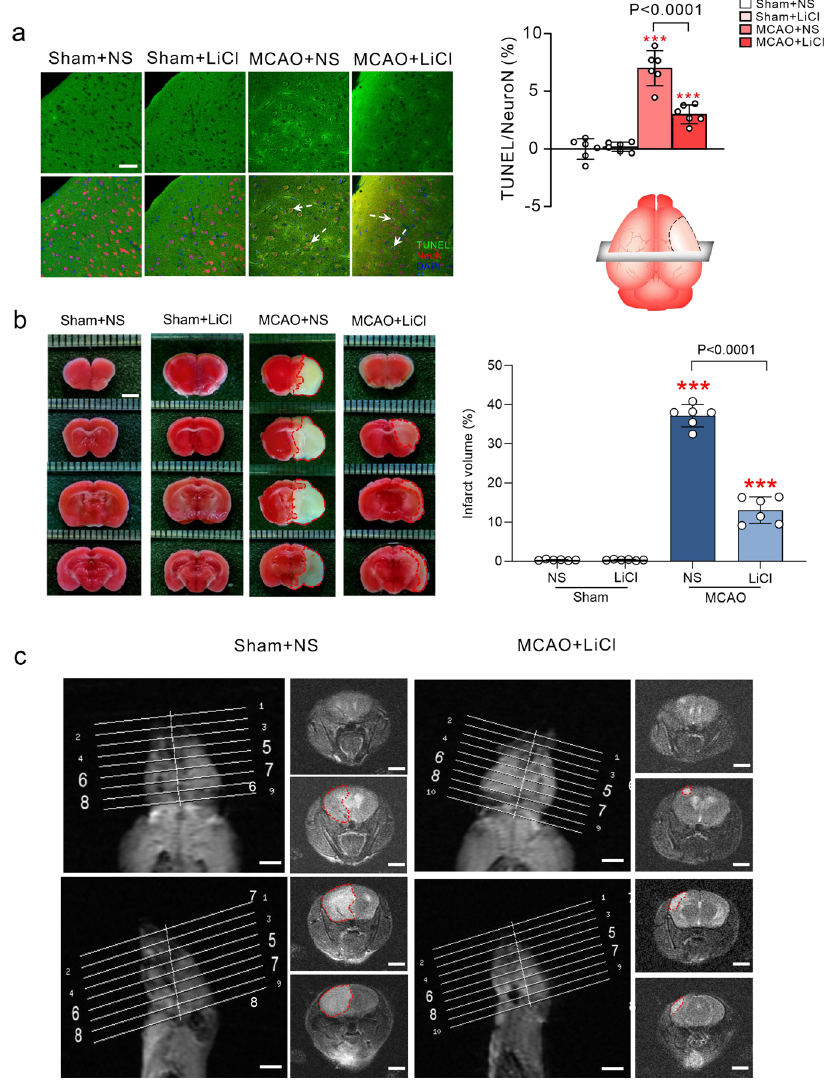
Fig. 7 Reduction of neuronal apoptosis and ischaemic volume by Li + . a TUNEL co-staining with neuronal marker NeuN and nucleus marker DAPI, and the relative ratio of Tunel-positive cells in NeuN-positive cells. Scar = 50 μ m. b TTC staining in brain slices, and the percentage of infarct volume. Scar = 3 mm. c The representative images show ischaemic regions on T2wt MRI. The T2wt MRI images of MCAO built mice treated with NS or LiCl. Scar = 5 mm. The percentage of neuronal apoptosis and ischaemic volume were calculated and plotted as mean ± SD. N = 6 per group. One-way ANOVA for comparisons including more than two groups; unpaired two-tailed t -test for two group comparisons. * p < 0.05, ** p < 0.01, *** p <